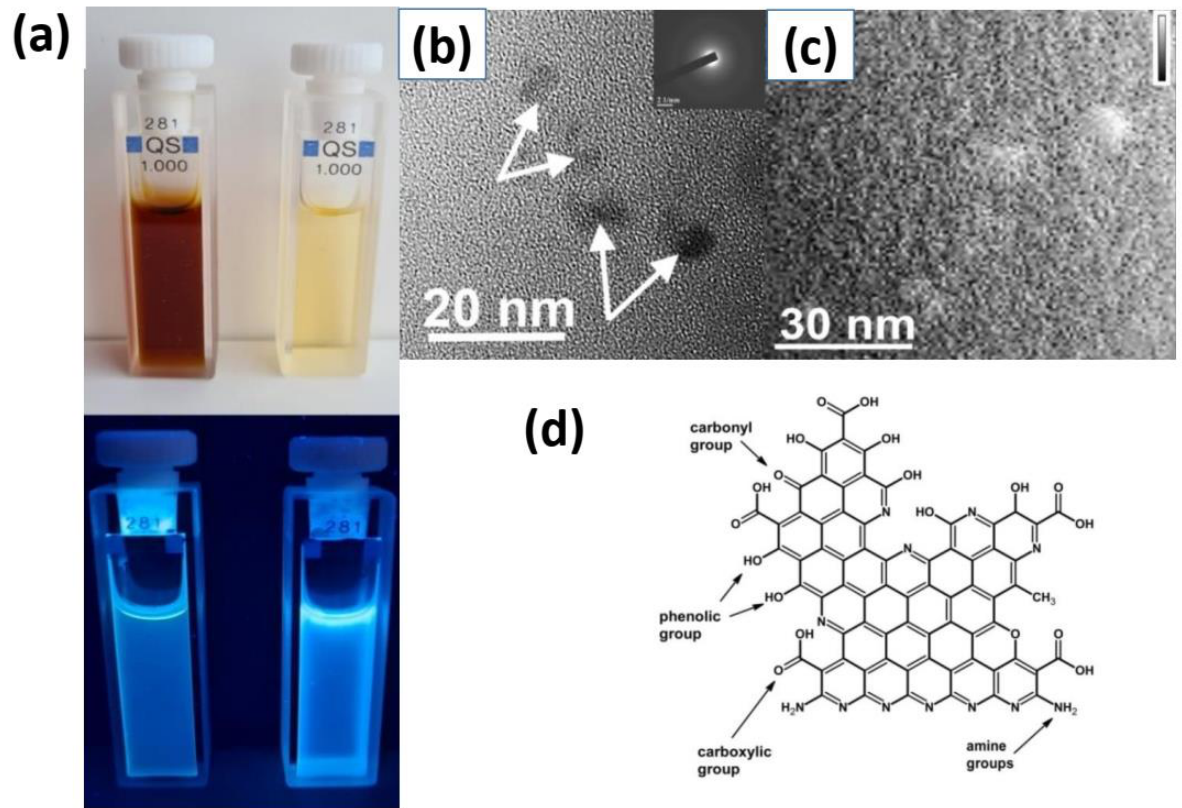
Figure 1. ( a ) Photos of water solutions with dispersed O, N-CDs in daylight and under the UV-light illumination. ( b ) TEM image of O, N-CDs (insert SAED pattern). The O, N-CDs are shown with arrows. ( c ) AFM images showing the topographic view of the O, N-CDs. ( d ) Schematic structure of a single O, N-CD adapted from [27].